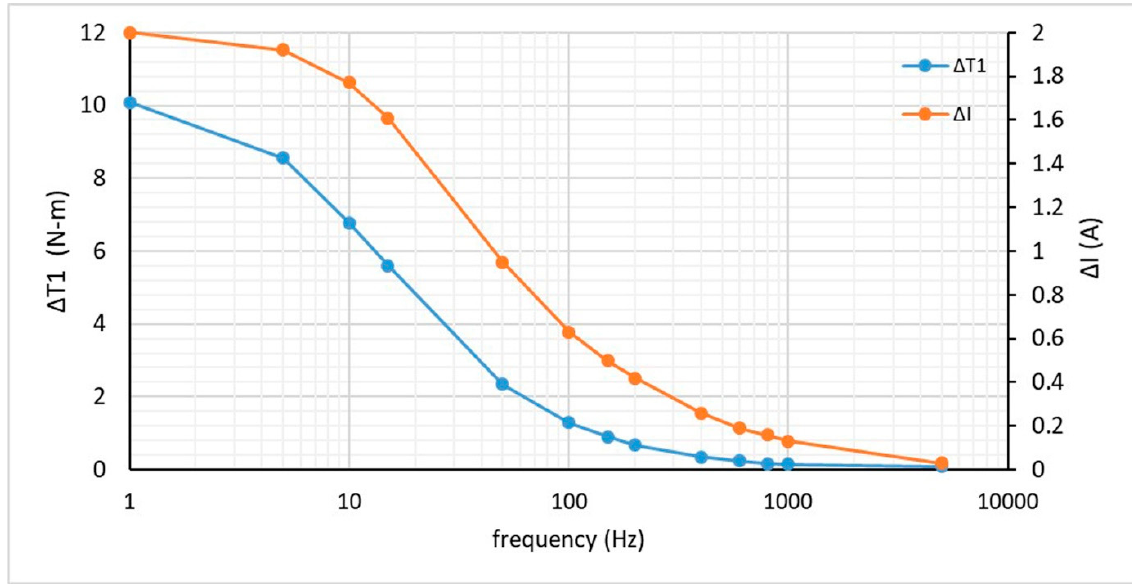
Figure 8. Ripple in the current ∆ I and torque ( ∆ T 1 ).